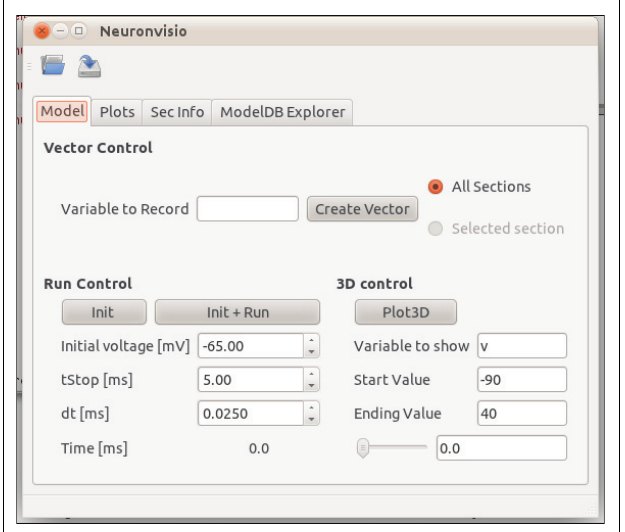
FIGURE 1 | Neuronvisio Controls main interface. From this interface it is possible to initialize and launch simulations, or to start the 3D viewer.The “Model” tab allows simulation duration (tstop), numerical integration interval (dt), and resting potential values (mV) to be